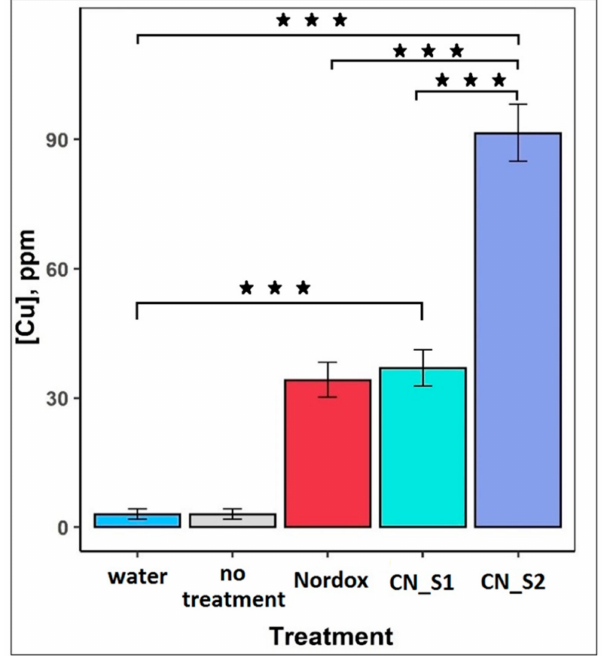
Figure 3. X-ray fluorescence spectrometry of copper concentration on tomato leaves after sprayed with the two copper nanoparticles (CN_S1 and CN_S2) at a concentration of 300 ppm. Water and Nordox (300 ppm) were used as control and standard reference, respectively. Estimated marginal means and standard errors of tomato leaves copper concentration from 15 plants per treatment are plotted. ***: p < 0.001 according to Tukey post hoc